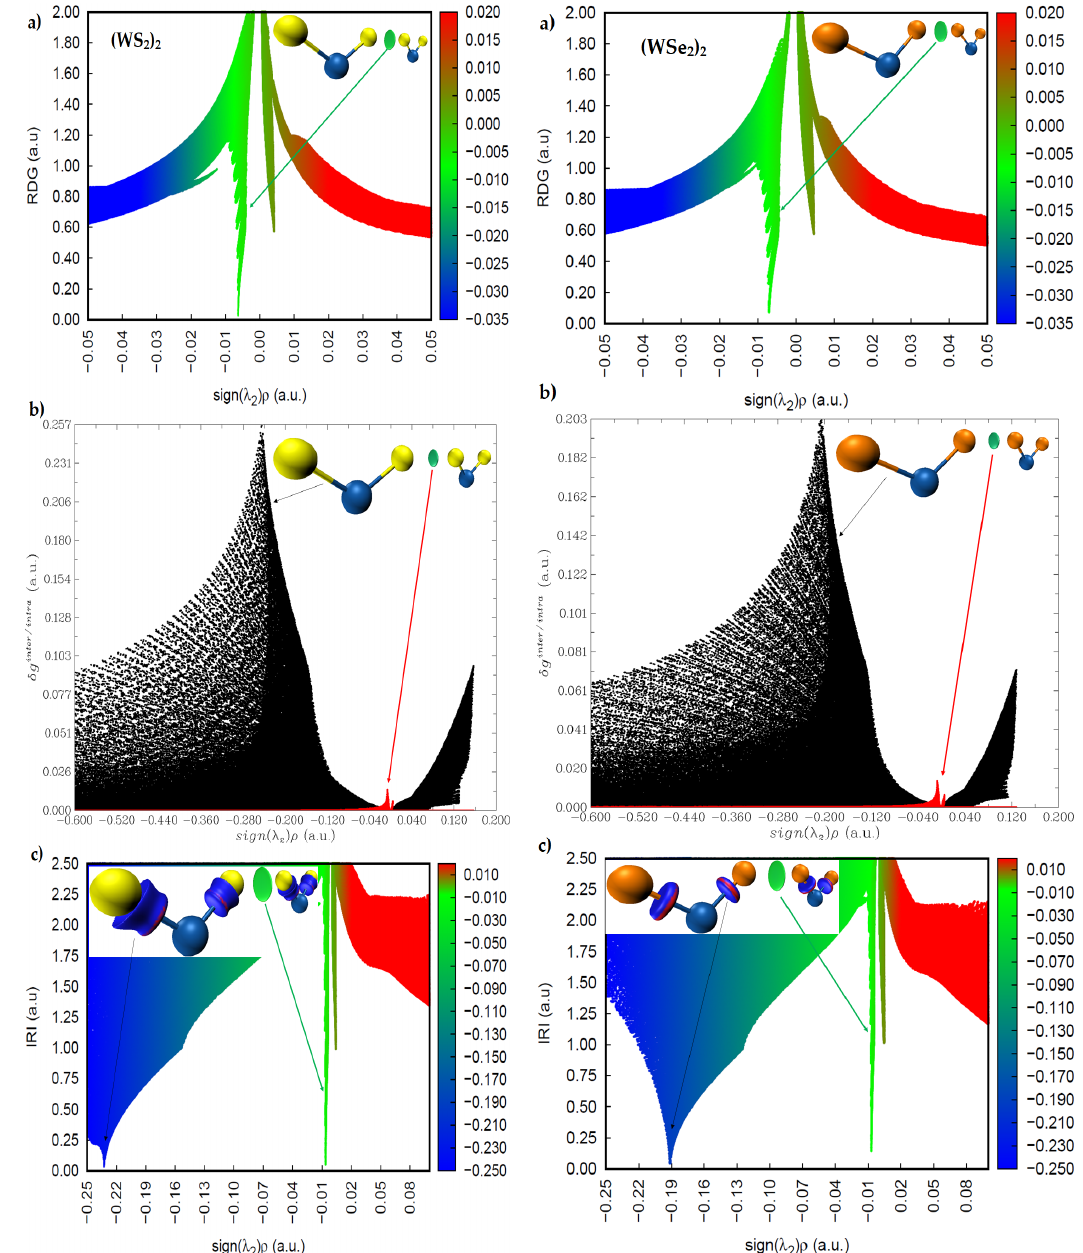
Figure 10. Comparison of the ( a ) sign( λ 2 ) × ρ vs . RDG plot with those of the ( b ) sign( λ 2 ) × ρ vs . IGM ( δ g inter/intra ) and ( c ) sign( λ 2 ) × ρ vs. IRI plots for left, (WS 2 ) 2 ; right, (WSe 2 ) 2 , obtained with M06-2X/Aug-cc-pVTZ(-PP). RDG, IGM( δ g inter / intra ), and IRI isosurface domains were obtained with isovalues of 0.4, 0.01, and 1.0 a.u., respectively.